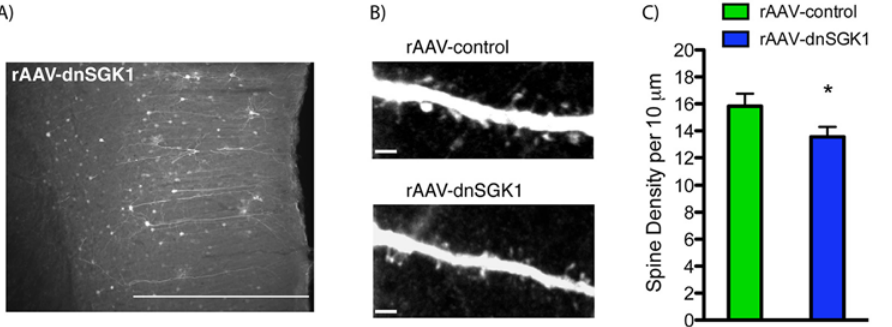
Fig 5. Impact of dnSGK1 overexpression on spine density in the medial PFC. rAAV-dnSGK1was infused into the medial PFC of rats, and 3 wk later, tissue was collected for analysis of spine density. (A) Low- power image of EGFP labeled layer II/III pyramidal neurons. Scale bar = 500 μ m. (B) High-power image of representative dendrite segments taken from rAAV-control or rAAV-dnSGK1 showing altered spine number. Scale bar = 4 μ m. (C) Spine density analysis of layer II/III pyramidal dendrite segments sampled from rAAV- dnSGK1 injected mPFC (mostly prelimbic cortex) (animals, n = 5; branches, n = 10, total dendritic length = 347.81 μ m) or rAAV-EGFP (animals, n = 7; branches, n = 14, total dendritic length = 404.46 μ m). Data are shown as mean ± SEM compared to the rAAV-EGFP control group (t(22) = 1.777, Student ’ s t test, * p < 0.05). For underlying data, see S1